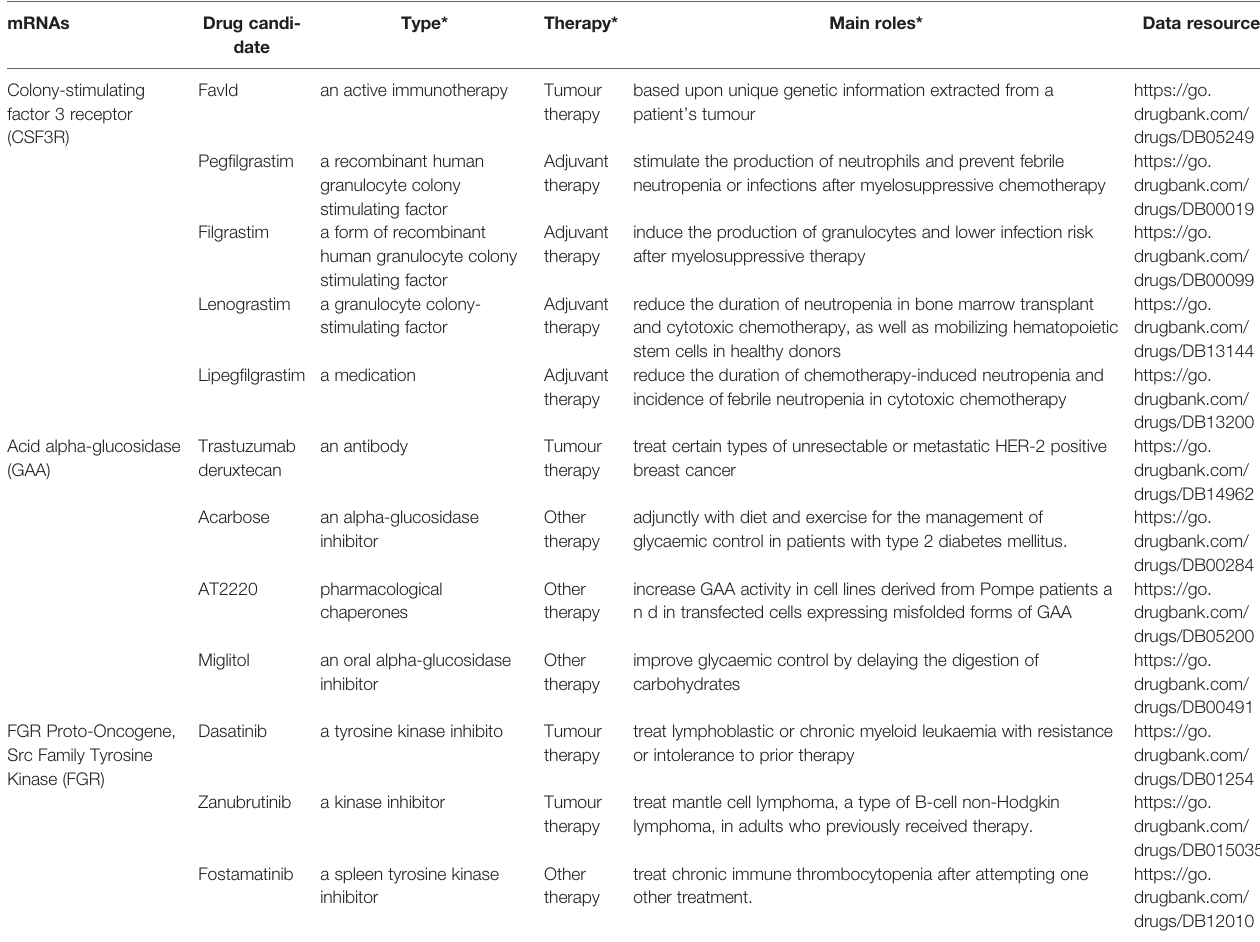
TABLE 8 | Potential drug candidates of mRNAs in the ceRNA networks in